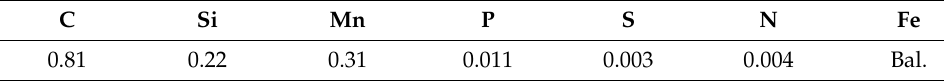
Table 1. Chemical composition of the investigated steel (wt%).